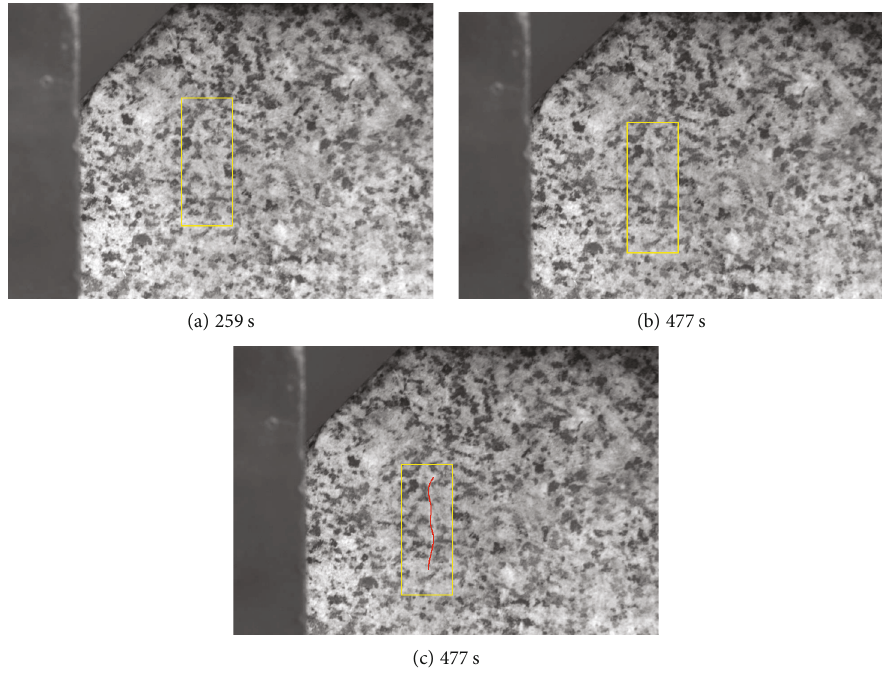
Figure 6: Trace of an example